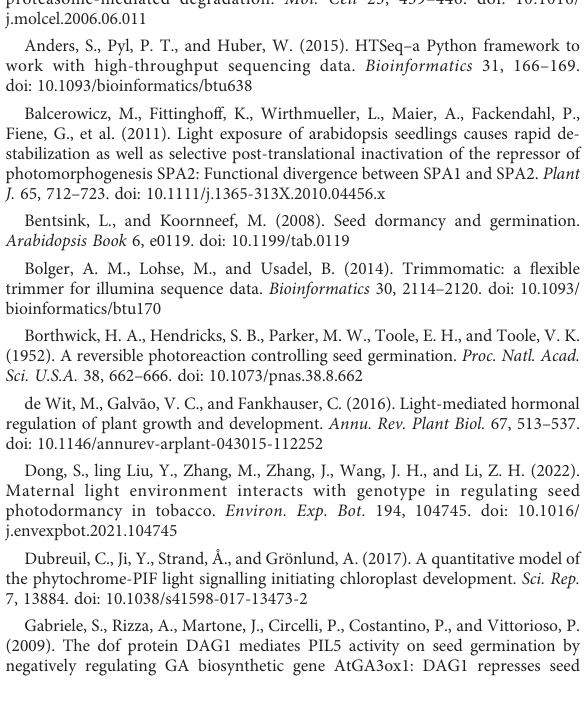
SUPPLEMENTARY FIGURE 11 Cellular components from different development stages seeds. (A) sko-